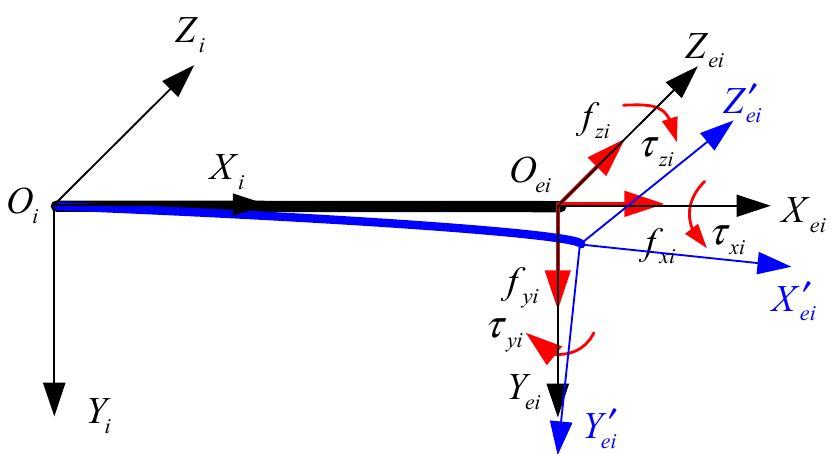
Figure 3. The differential motion of the link coordinate system is caused by link deformation. The differential motion vector formation can be derived based on the analysis of the extension, bending, and torsion